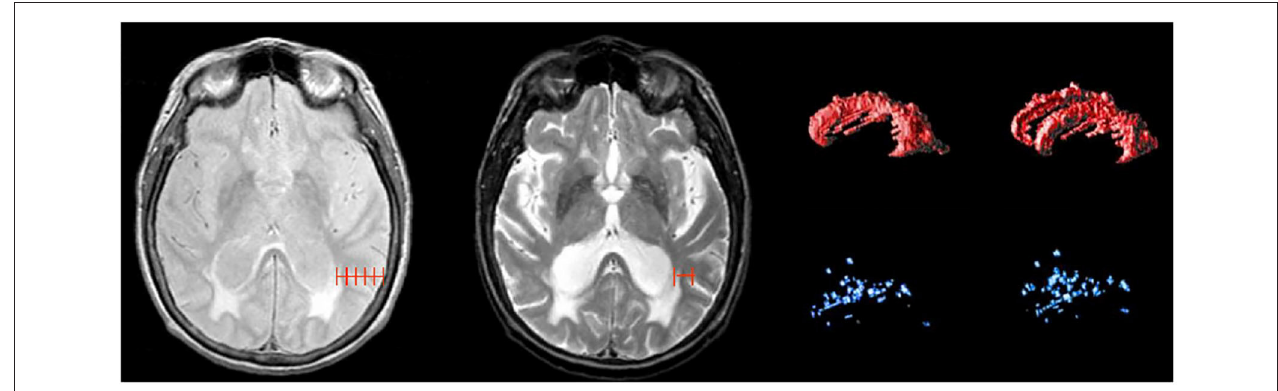
FIGURE 8 | Shows different methods for segmenting periventricular and deep WMH. Left image shows a proportional distance from the ventricular lining to the dura mater; middle image shows an arbitrary distance of 13mm from ventricles, right image shows 3D connectivity algorithm supported by ONDRI, displayed as 3D volume renderings of pWMH (red) and dWMH (blue) shown in sagittal and slightly tilted anterior